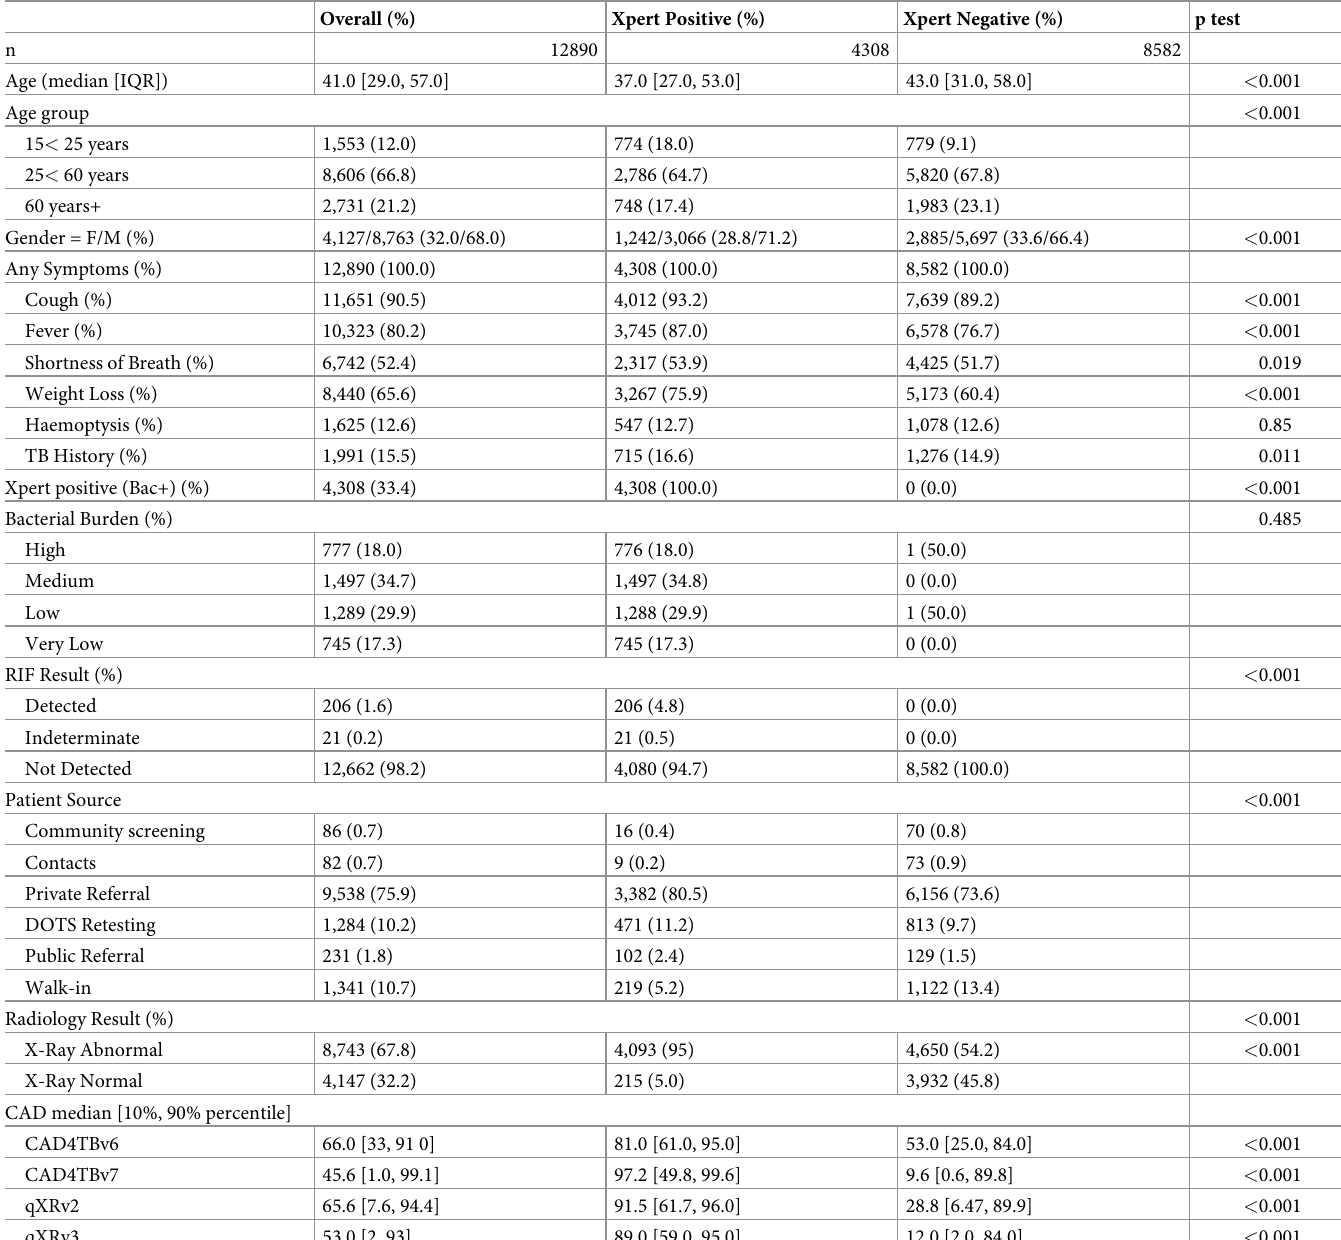
Table 1. Characteristics of the 12,890